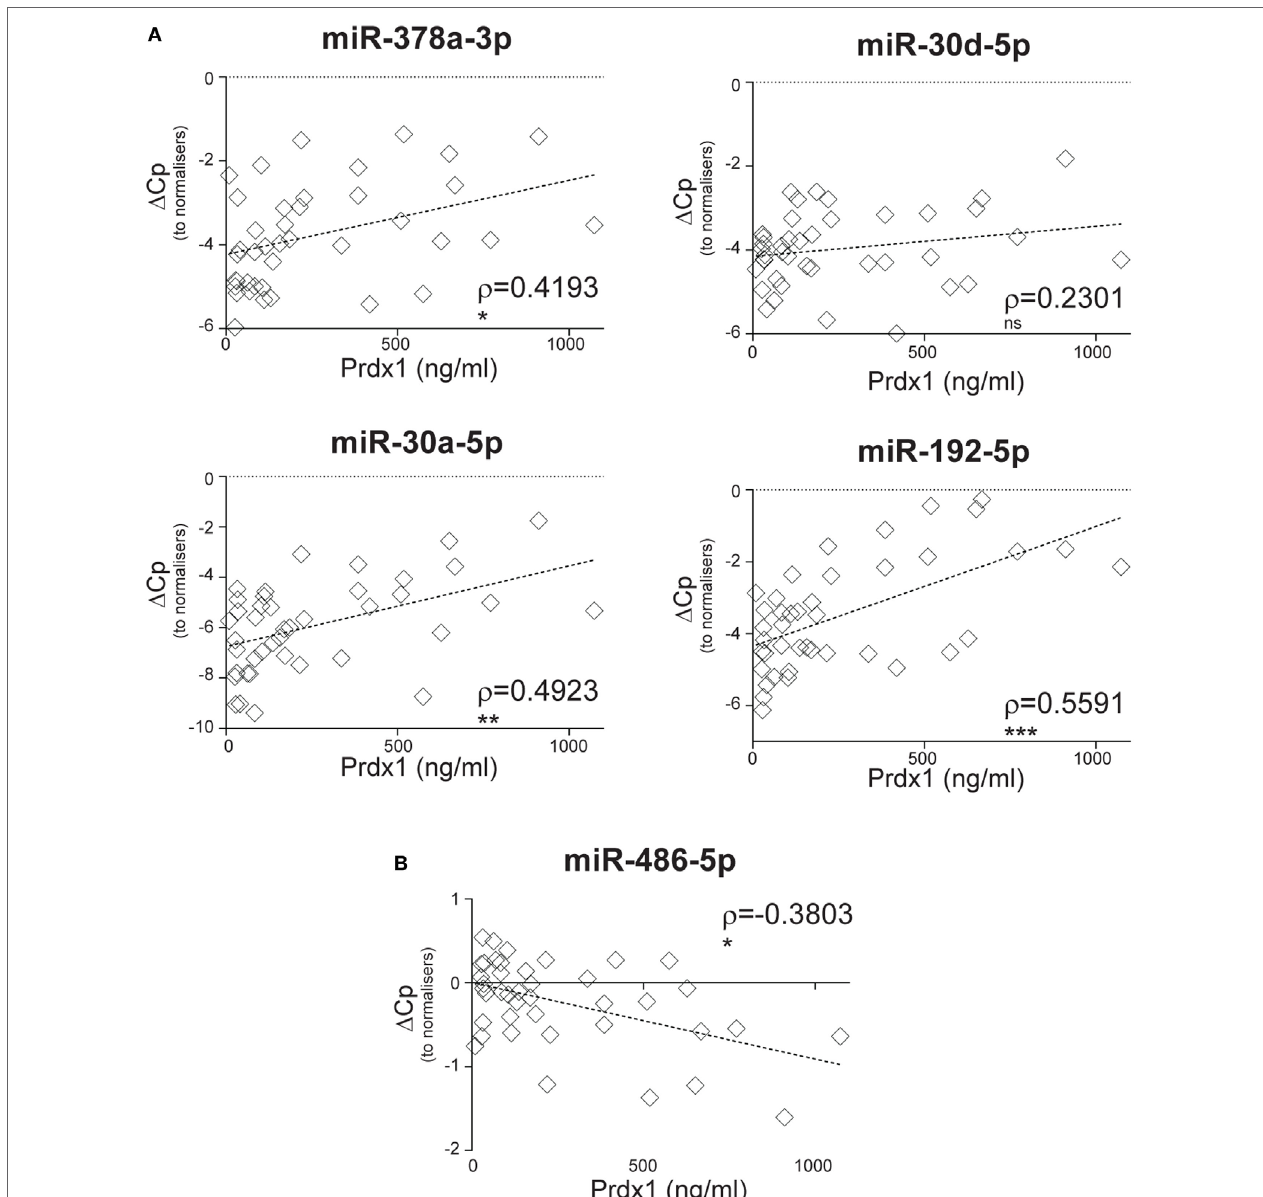
FigUre 5 | Circulating inflammatory-relevant microRNA levels positively correlate with markers of immunological stress, peroxiredoxin-1 (Prdx1). In miRNA qPCR arrays, within each patient’s specimen, crossing point (Cp) of individual microRNAs (miRNAs) (open rhombi) were normalized as in Figure 1 and analyzed in correlation with levels of plasma inflammatory stress marker, Prdx-1. Each symbol represents an individual patient. Correlation trends are shown with the linear regression model including Spearman rho ( ρ ) and the significances of the correlations (* p ≤ 0.05; ** p ≤ 0.005; and *** p ≤ 0.0005 or ns, non-significant) for (a) miR-378a-3p, miR-30a-5p, miR-30d-5p, and miR-192-5p, and (B) miR-486-5p in non-infective systemic inflammatory response syndrome patients ( n =